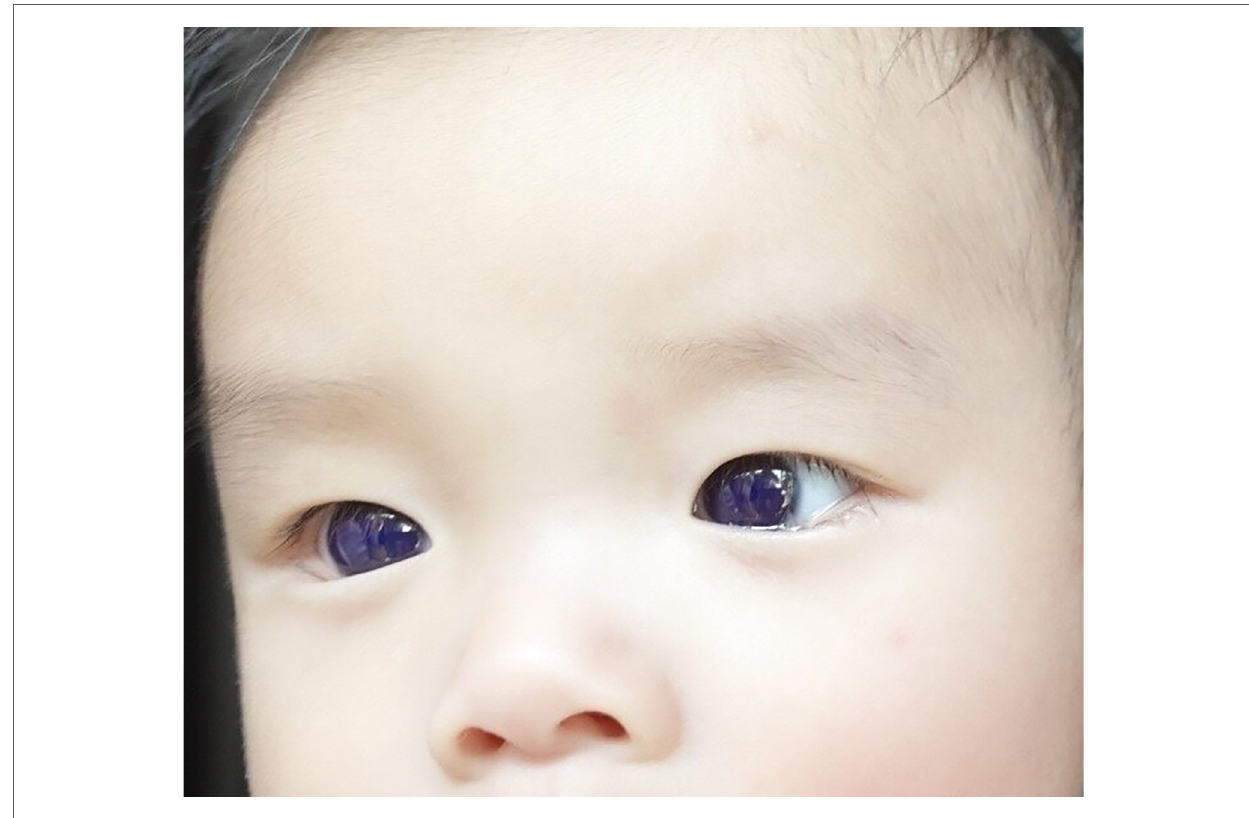
FIGURE 1 The bright blue color of the cornea at 18 h after favipiravir